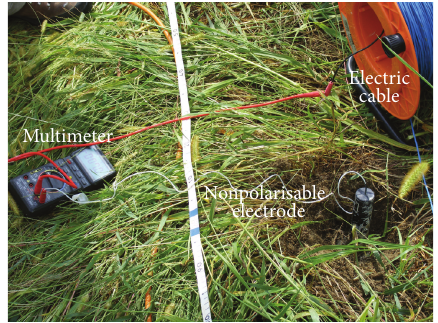
Figure 1: Instrumentation for SP measurement